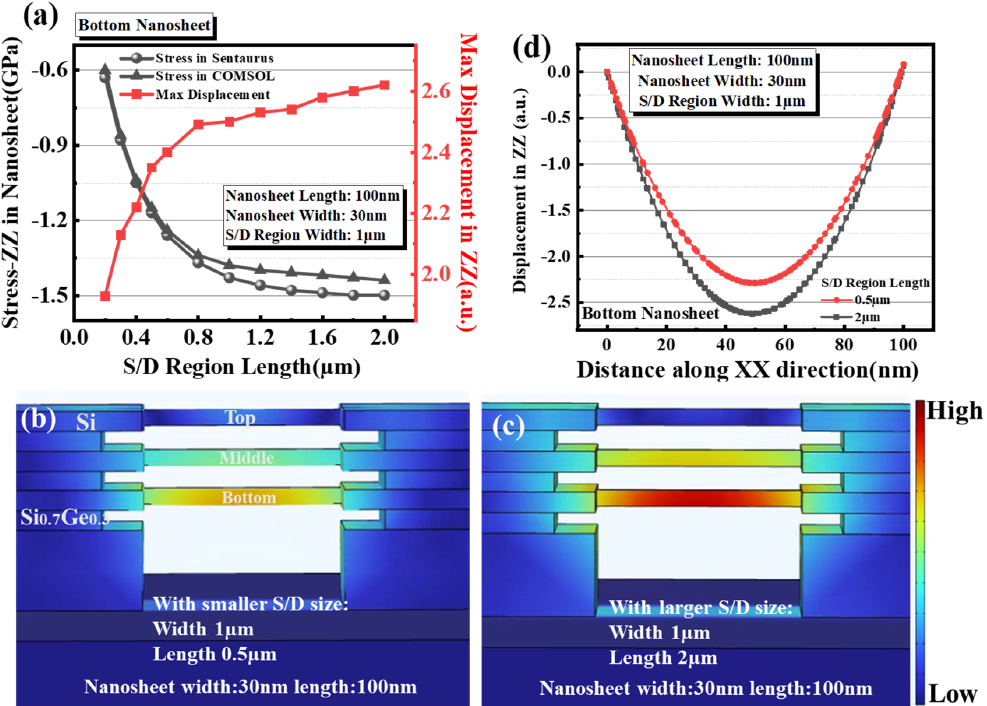
Figure 5. ( a ) The stress values calculated by Sentaurus and COMSOL and displacement in bottom nanosheet channel as a function of varied S/D region length. GAA device with different S/D length ( b ) 0.5 µm and ( c ) 2 µm schematics of displacement mapping of top, middle and bottom nanosheet in COMSOL (Si nanosheet length: 100 nm width: 30 nm). ( d ) Extracted displacement of bottom nanosheet along XX direction with S/D region length 0.5 µm and 2 µm.